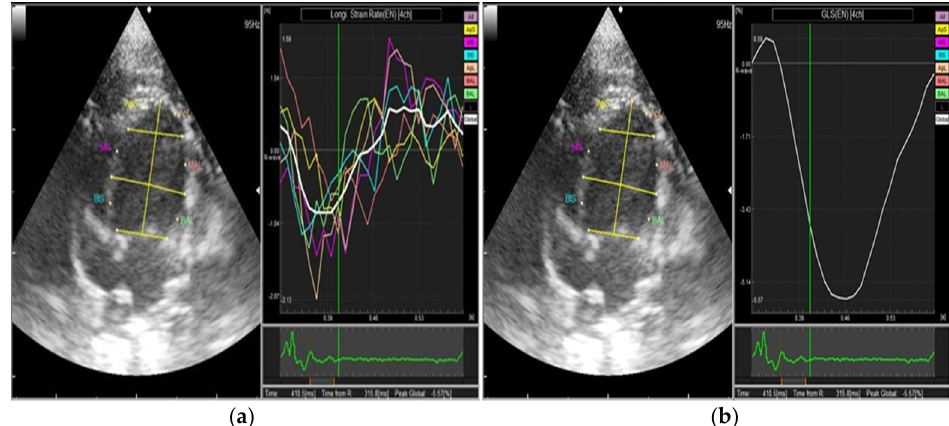
Figure 1. Two-dimensional speckle tracking echocardiography (2DSTE) in rats obtained from the left apical 4-chamber view. The entire left ventricular endocardium was traced for evaluation of strain rate (SR, a ) and global longitudinal strain (GLS, b ).